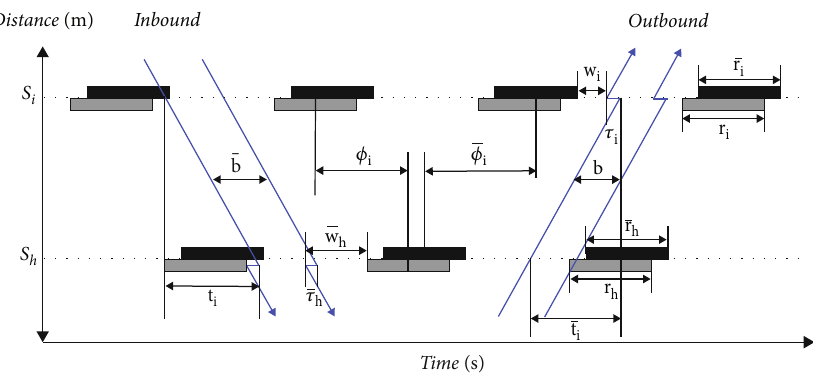
Figure 3: Time – space diagram for MAXBAND (symbols de fi ned in Table 1).